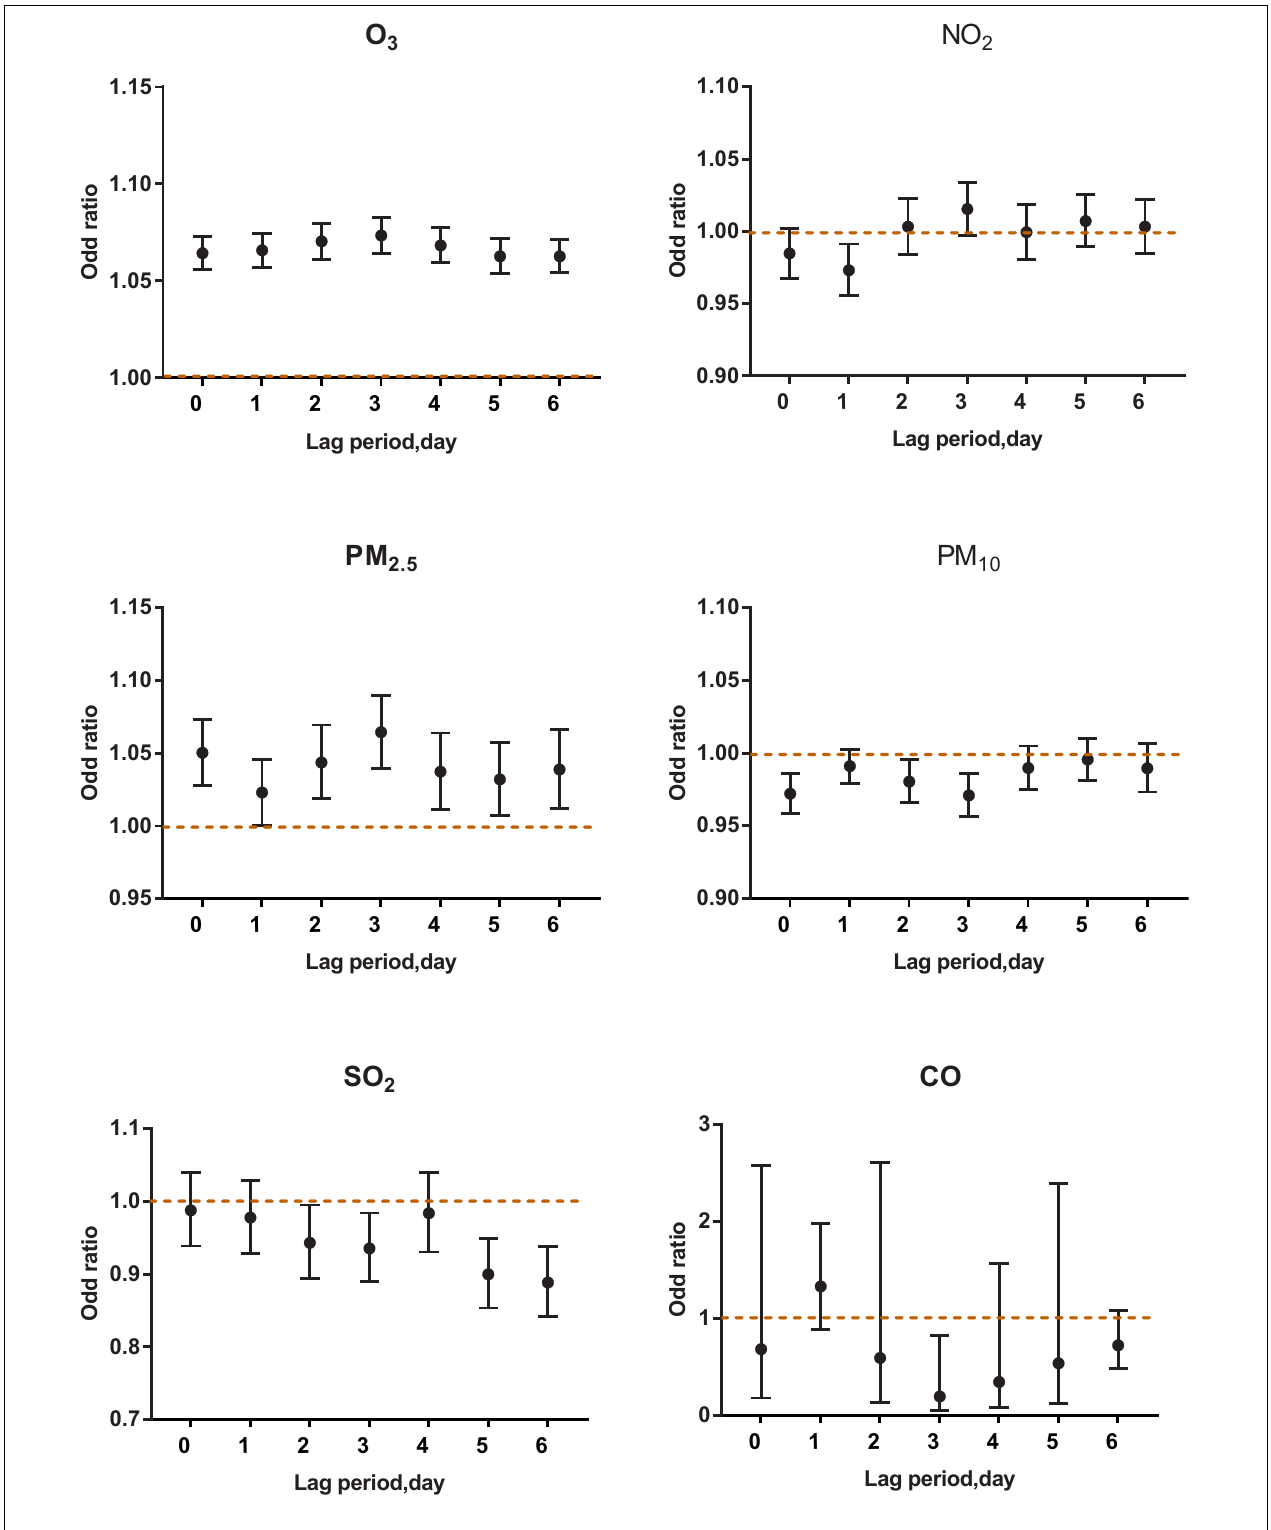
FIGURE 4 | Air pollutants in different lag periods in the multi-pollutant model when O 3 -8 h was higher than 100 µ g/m 3 .